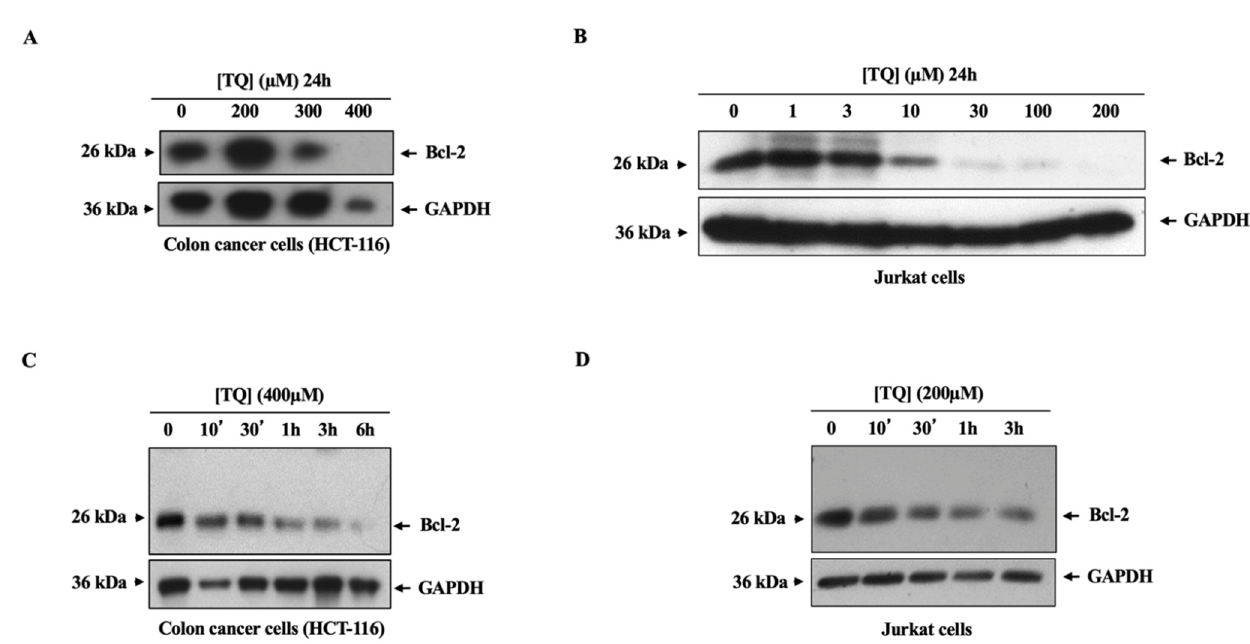
Figure 5. Dose- and time-dependent effects of TQ on the protein expression of Bcl-2 in cancer cells. HCT-116 cells were exposed to increasing concentrations of TQ for 24 h ( A ) or exposed to 400 µ M TQ for different times ( C ). Jurkat cells were exposed to increasing concentrations of TQ for 24 h ( B ) or exposed to 200 µ M TQ for different times ( D ). Expres-sion of Bcl-2 was analyzed via Western blotting, as described in the Materials and Methods.